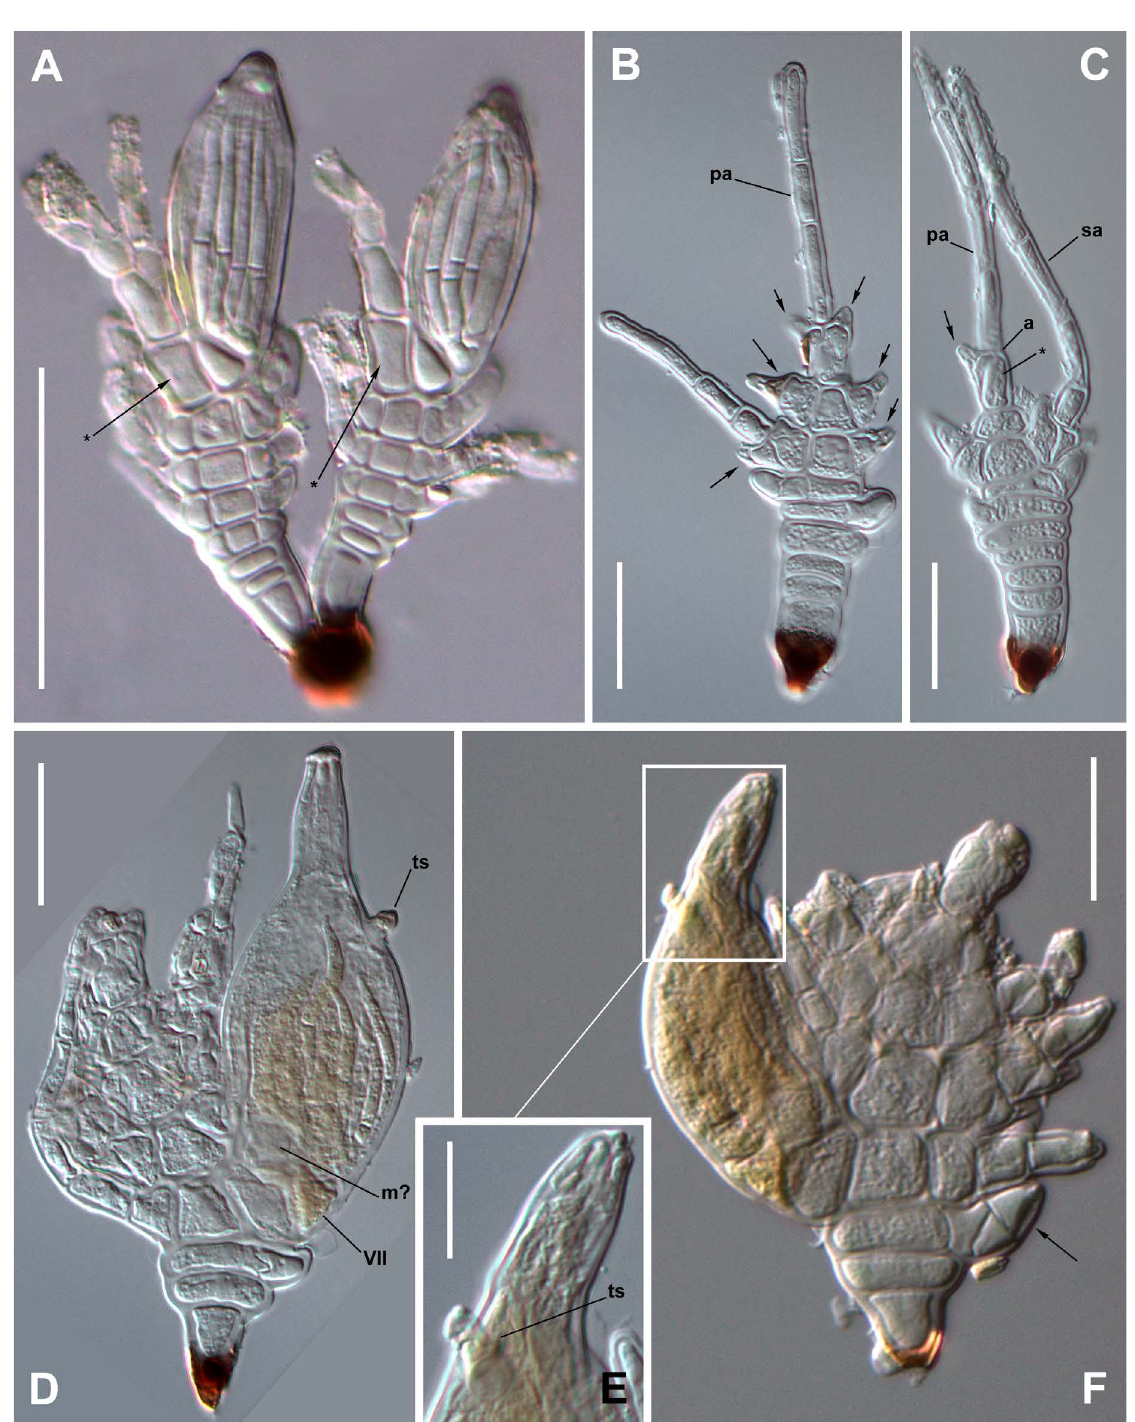
Fig. 10. Euphoriomyces spp. A . E. magnicellulatus Santam. Paired mature thalli, with elongated cell of receptacle (*). – B – F . E. smicri Santam. sp. nov. B – C . Immature thalli showing antheridia (arrows), primary appendage (pa), primary septum (a), and uppermost receptacular axial cell (*). D . Mature thallus showing cells VII, probably m (m?) and trichogyne stump (ts). E . Detail of the perithecial apex from F, with trichogyne stump (ts). F . Mature thallus with a labelled perithecial initial (arrow). Scale bars: A = 50 µm; B–D, F = 20 µm; E = 10 µm. Photographs from slides ZMUC C-F-124132 (A), and ZMUC C-F-122821 (holotype)